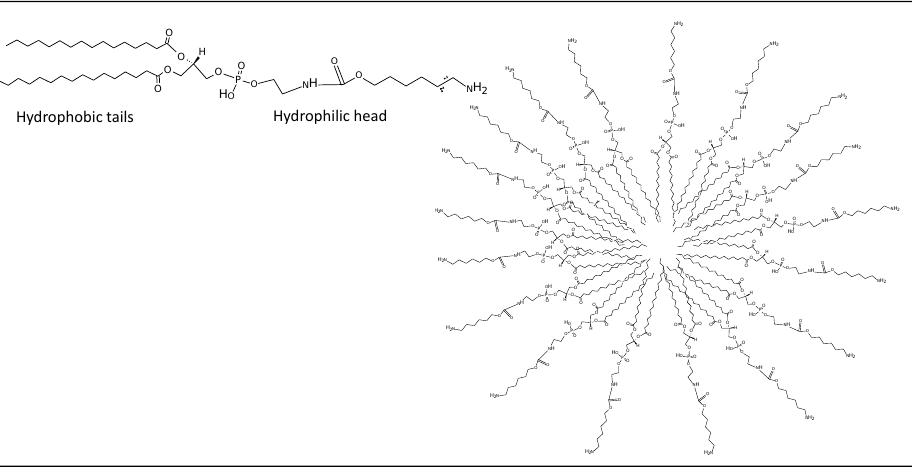
Figure 5. Schematic representation of dendrimer (right). Chemical structure of the monomer (left).